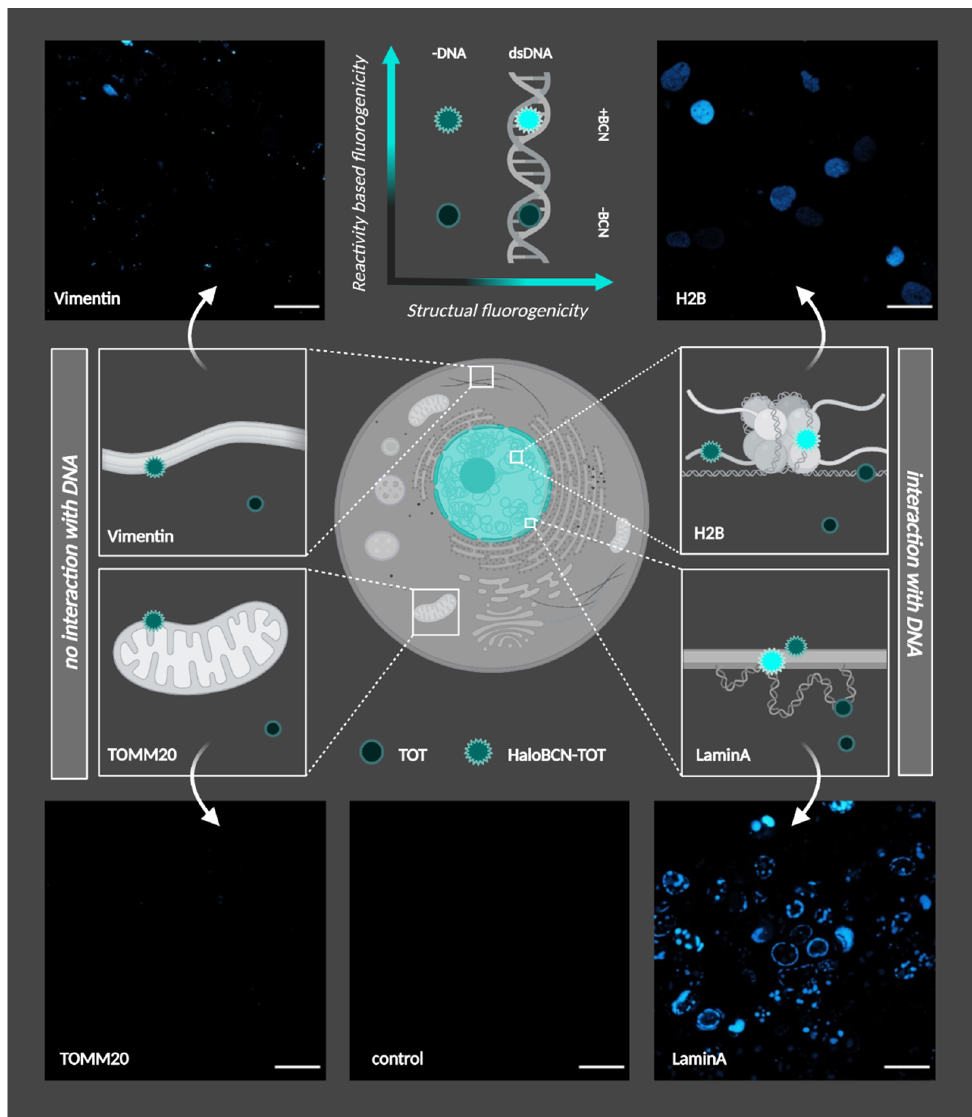
Figure 5. Confocal microscopy images of transfected HEK293T cells expressing the DNA interacting nuclear proteins H2B-HaloTag ( top, right ) or LaminA-HaloTag ( bottom, right ) and the non-DNA interacting cytosolic proteins Vimentin-HaloTag ( top, left ) and TOMM20-HaloTag ( bottom, left ) after treatment with HaloBCN (3 µ M) and TOT (6 µ M). The color calibration code shows the fluorescence intensity levels of TOT ( top, middle ). The control image refers to TOT -treated non-transfected cells ( bottom, middle ). Spectral detection: λ exc : 488 nm/ λ em : 500–800 nm; Scale bar = 25 µ m. Created with BioRender.com, (accessed on 10 December